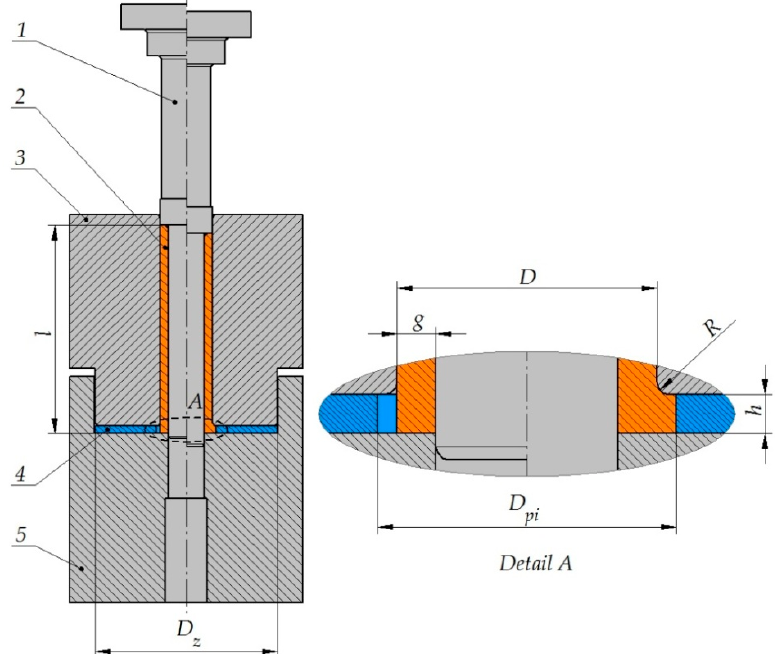
Figure 1. Schematic design of incremental radial extrusion of flange: 1—punch, 2—billet, 3—die, 4—ring, 5—base.